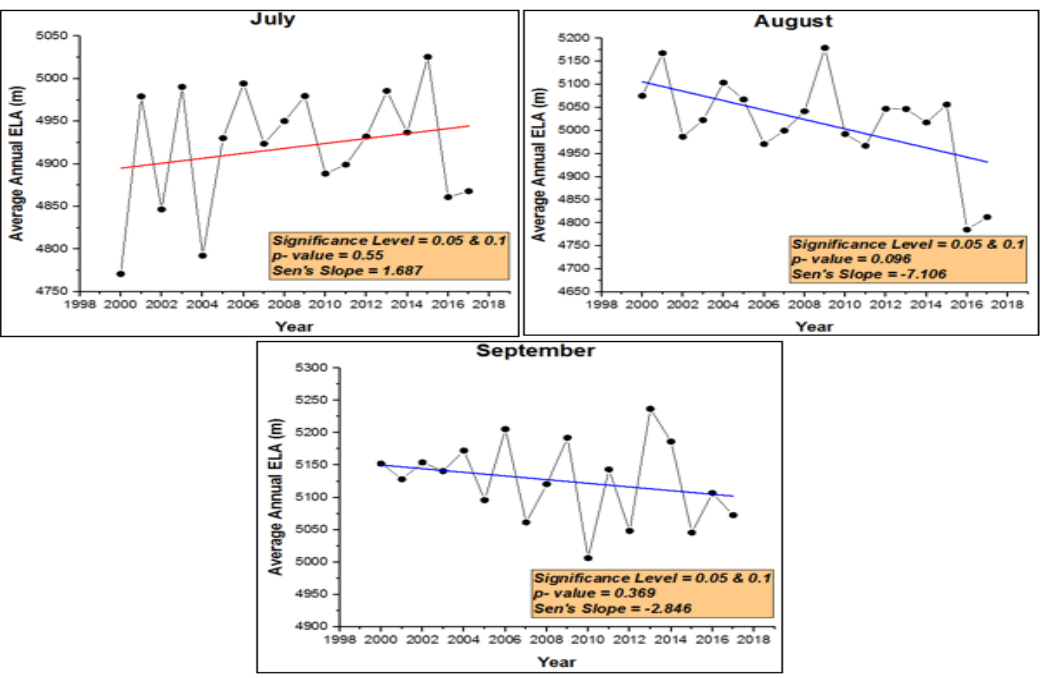
Figure 6. Trend analysis of monthly ELAs for the months of July, August and September during the years 2000 to 2017 for the Hunza River basin; red trend line shows positive trend, whereas blue trend line shows negative trend .